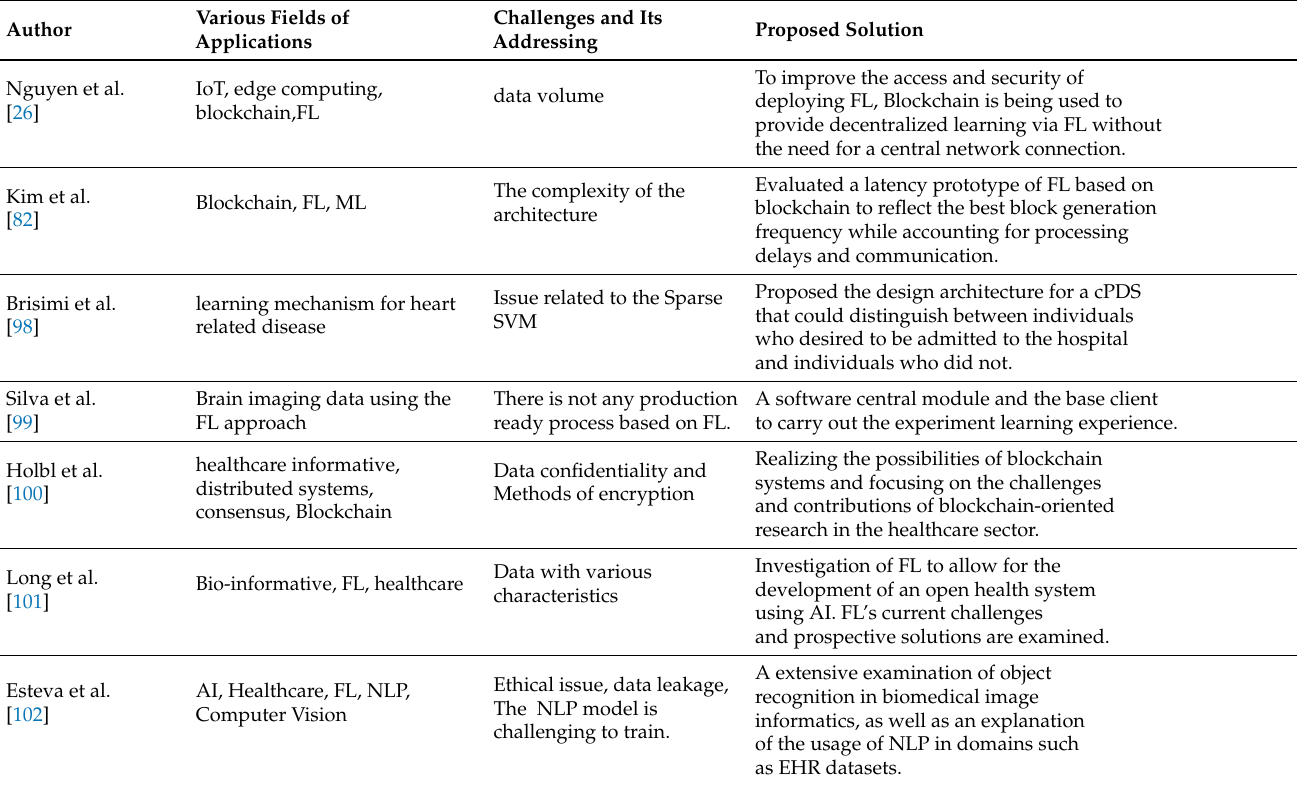
Table 8. Applicative view of FL with ML/DL in IoMT setups with potential challenges and scope.